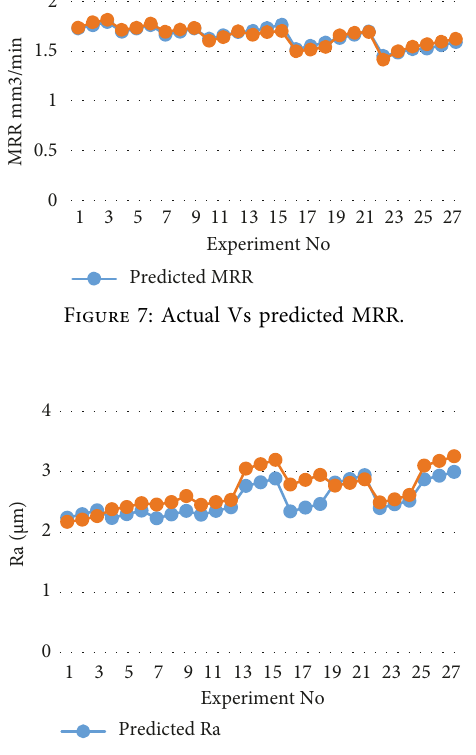
Figure 8: Actual Vs predicted